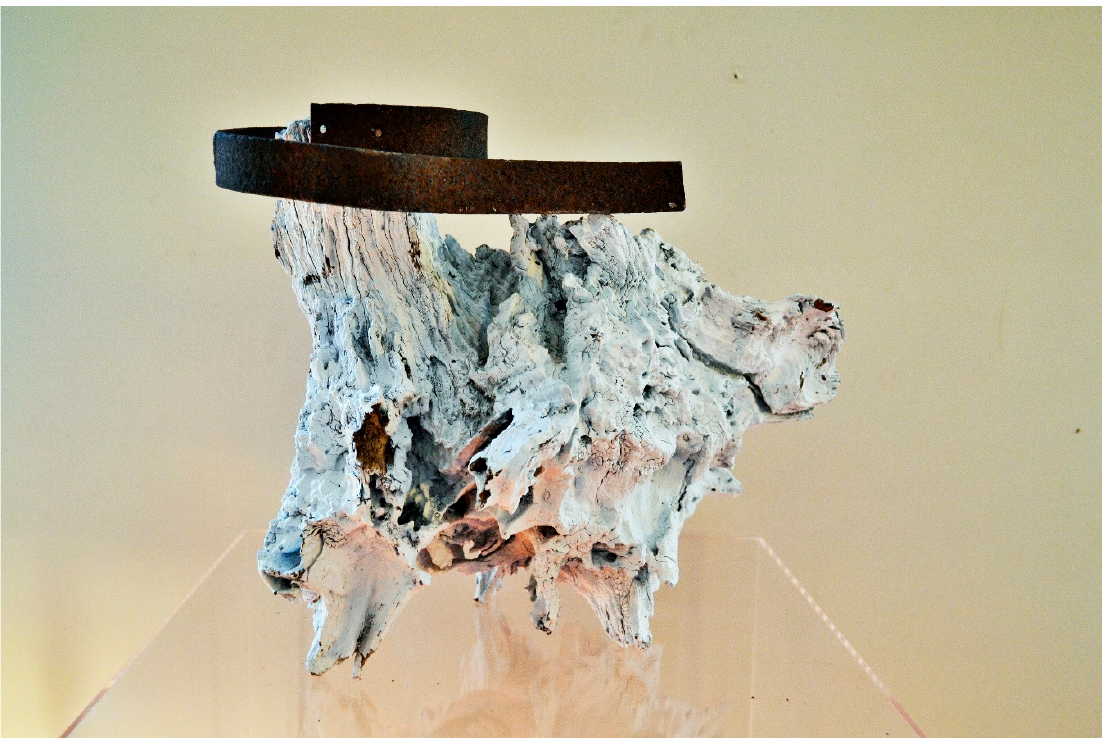
Figure 9. Perhaps a Bull. Photo by Agricubismo ® .